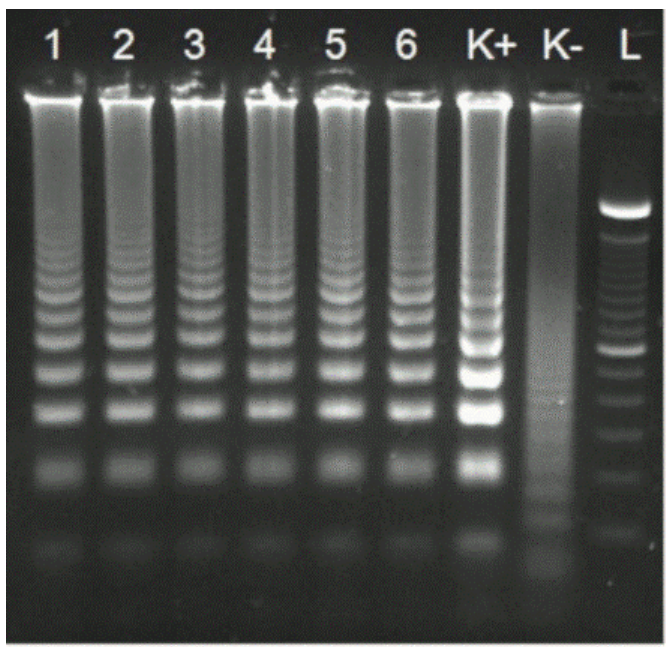
Figure 3. Amplification of LAMP for DNA extracted from anchovy paste samples experimentally infected with Anisakis spp. larvae (Lanes 1–6). Lane K+: Positive control, Lane K − : Negative control, Lane L: 100 bp DNA ladder.